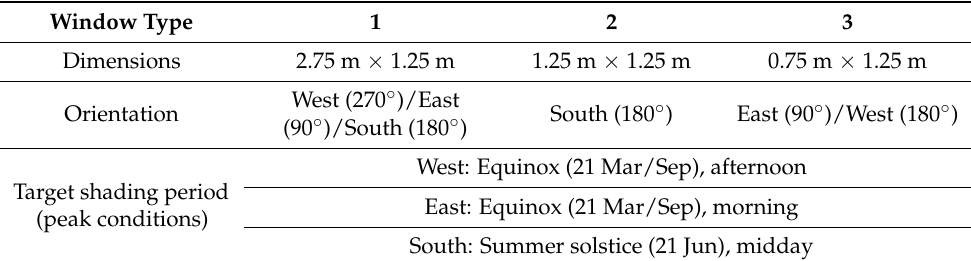
Table 7. Window specifications and shading design